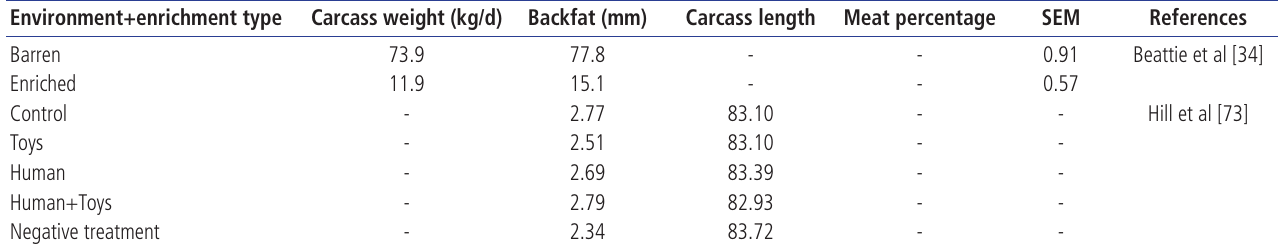
Table 2. Carcass characteristics measurements from pigs in different housing environment and using different enrichment types Environment+enrichment